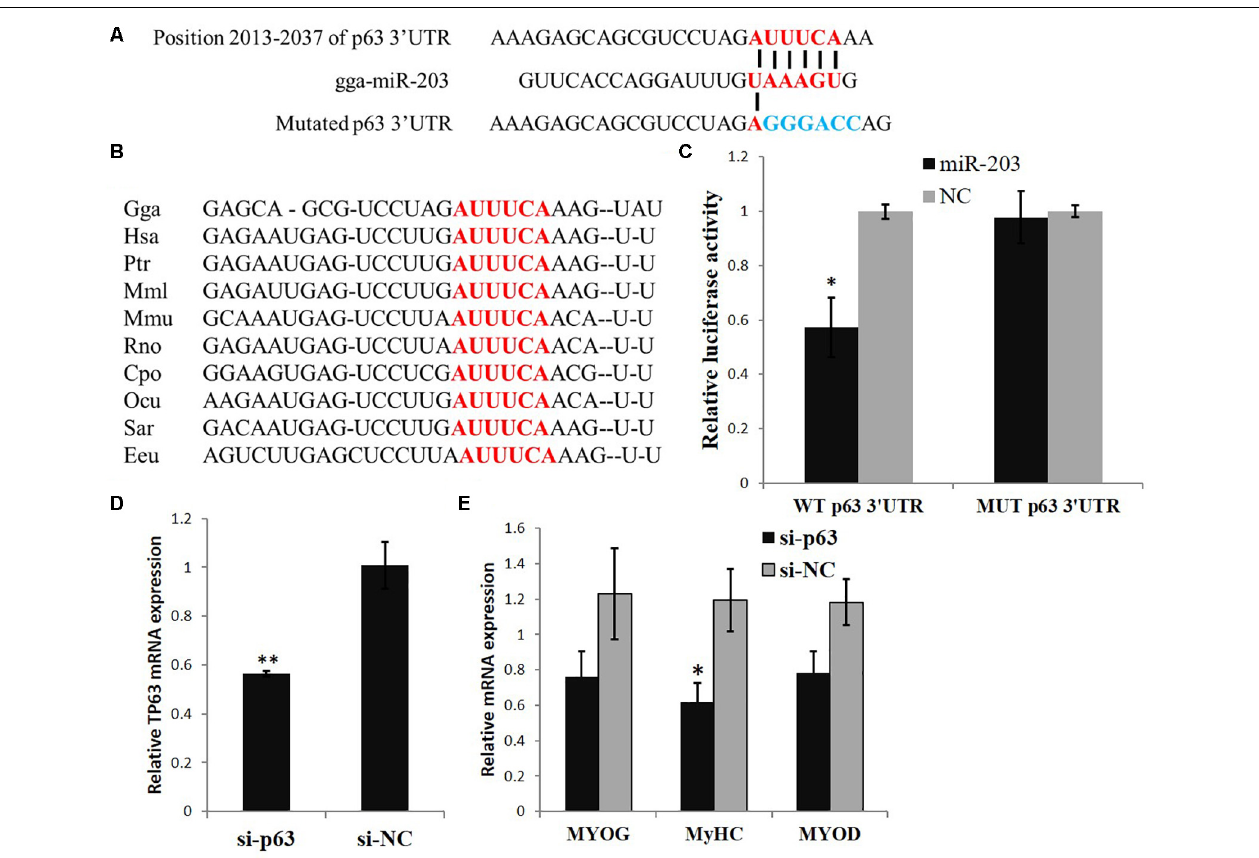
FIGURE 1 | TP63 is a gga-miR-203 target gene and is involved in myogenic differentiation. (A) Predicted binding site and mutated site (blue) of gga-miR-203 in the 3 (cid:48) UTR of TP63 . (B) The predicted binding site of gga-miR-203 in the 3 (cid:48) UTR of TP63 is highly conserved among vertebrates. (C) Luciferase reporters were transfected into DF-1 cells with the gga-miR-203 mimic or negative control (NC) duplexes, and luciferase activity was determined 36 h after transfection. (D) TP63 specific siRNA transfection significantly inhibited TP63 mRNA expression in myoblast. (E) The expression of muscle differentiation marker genes in myoblast after the transfection of TP63-specific siRNA. The values are presented as the mean ± SEM ( n = 3). An independent samples t -test was used to analyze the statistical differences between groups. ∗ p < 0.05; ∗∗ p < 0.01.